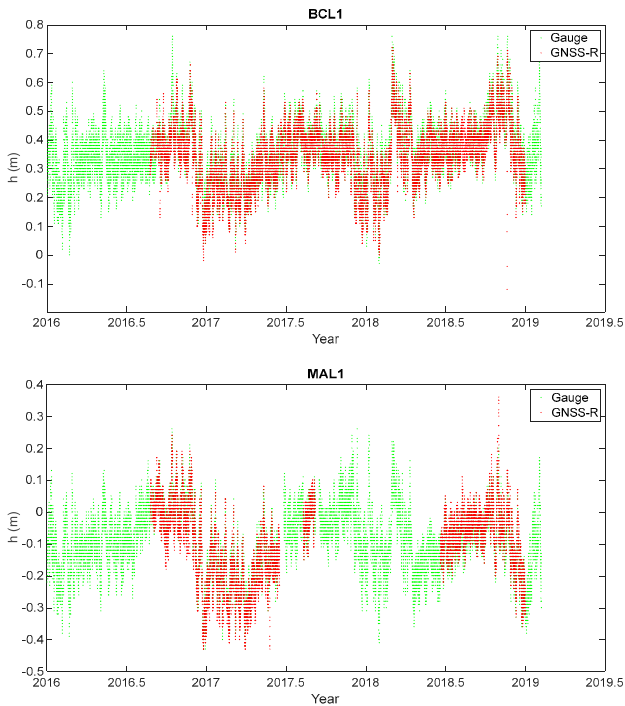
Figure 2. Sea level at BCL1 ( up ) and MAL1 ( down ) from GNSS-R IM and tide